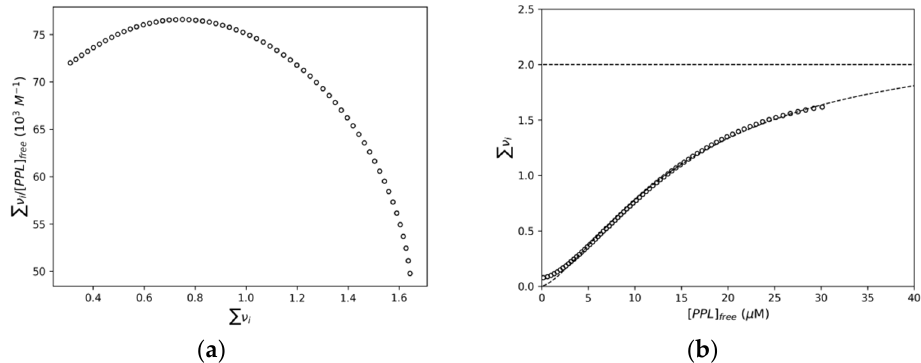
Figure 6. ( a ) Scatchard plot for the interaction of NBD and PPL obtained at 293 K based on IDF data. ( b ) Hill’s plot for the interaction of NBD and PPL.